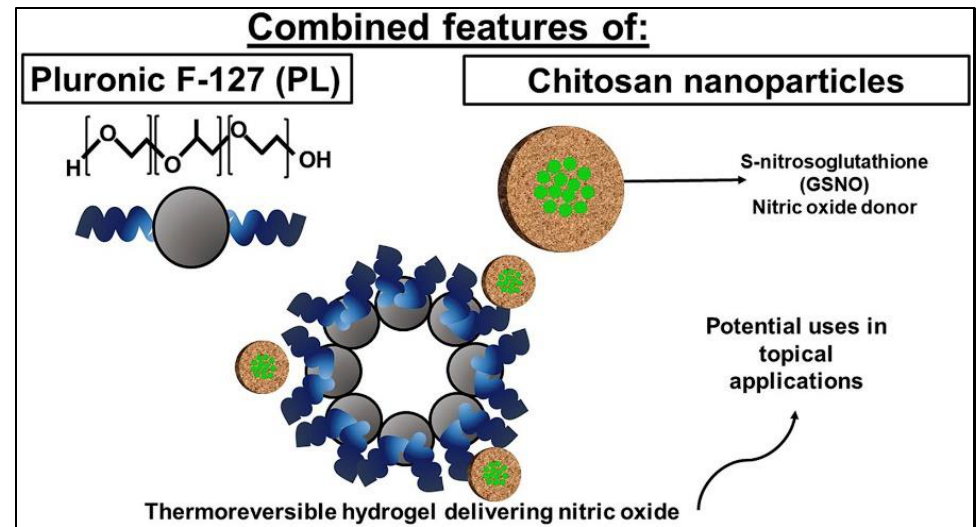
Figure 7. Schematic illustration of GSNO loaded chitosan nanoparticles in pluronic F-127 hydrogel [52].